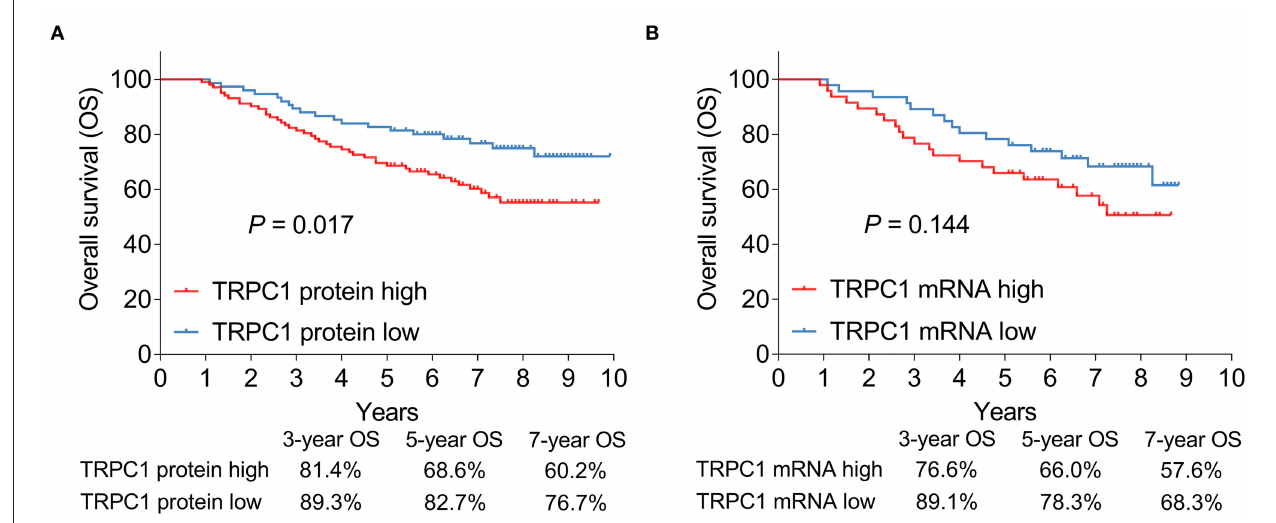
FIGURE 3 | Association of tumor TRPC1 expression with prognosis in patients with RCC. Association of TRPC1 protein expression (A) and TRPC1 mRNA expression (B) with overall survival (OS). TRPC1, transient receptor potential channel 1; OS, overall survival; mRNA, messenger RNA; RCC, renal cell carcinoma.